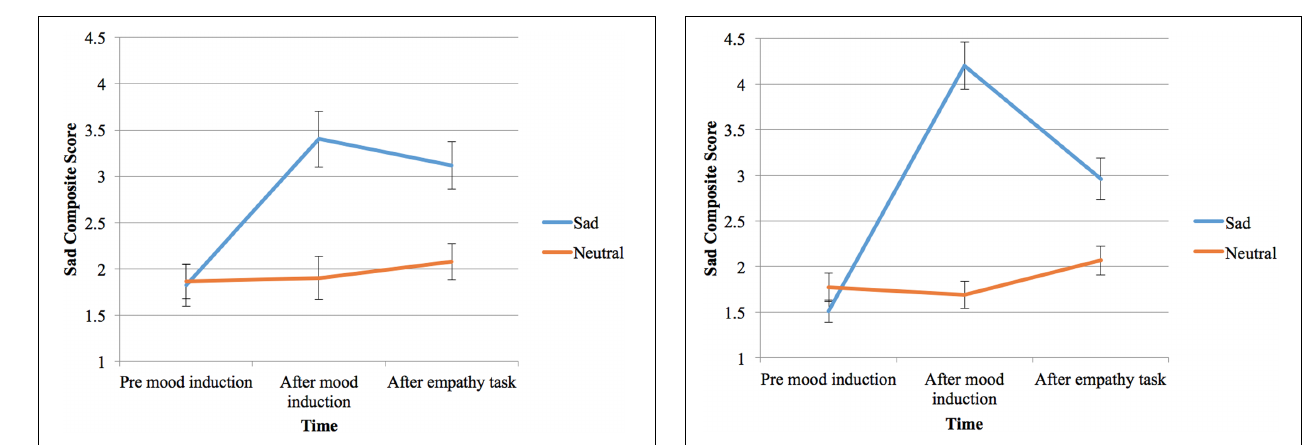
FIGURE 3 | Participant sample two’s self-reported mood (composite score from 0 to 10, 0 = not sad at all and extremely happy; 10 = not happy at all and extremely sad) before and after two types of mood induction (sad or neutral), and at the end of the empathy task (bars shown are standard errors).